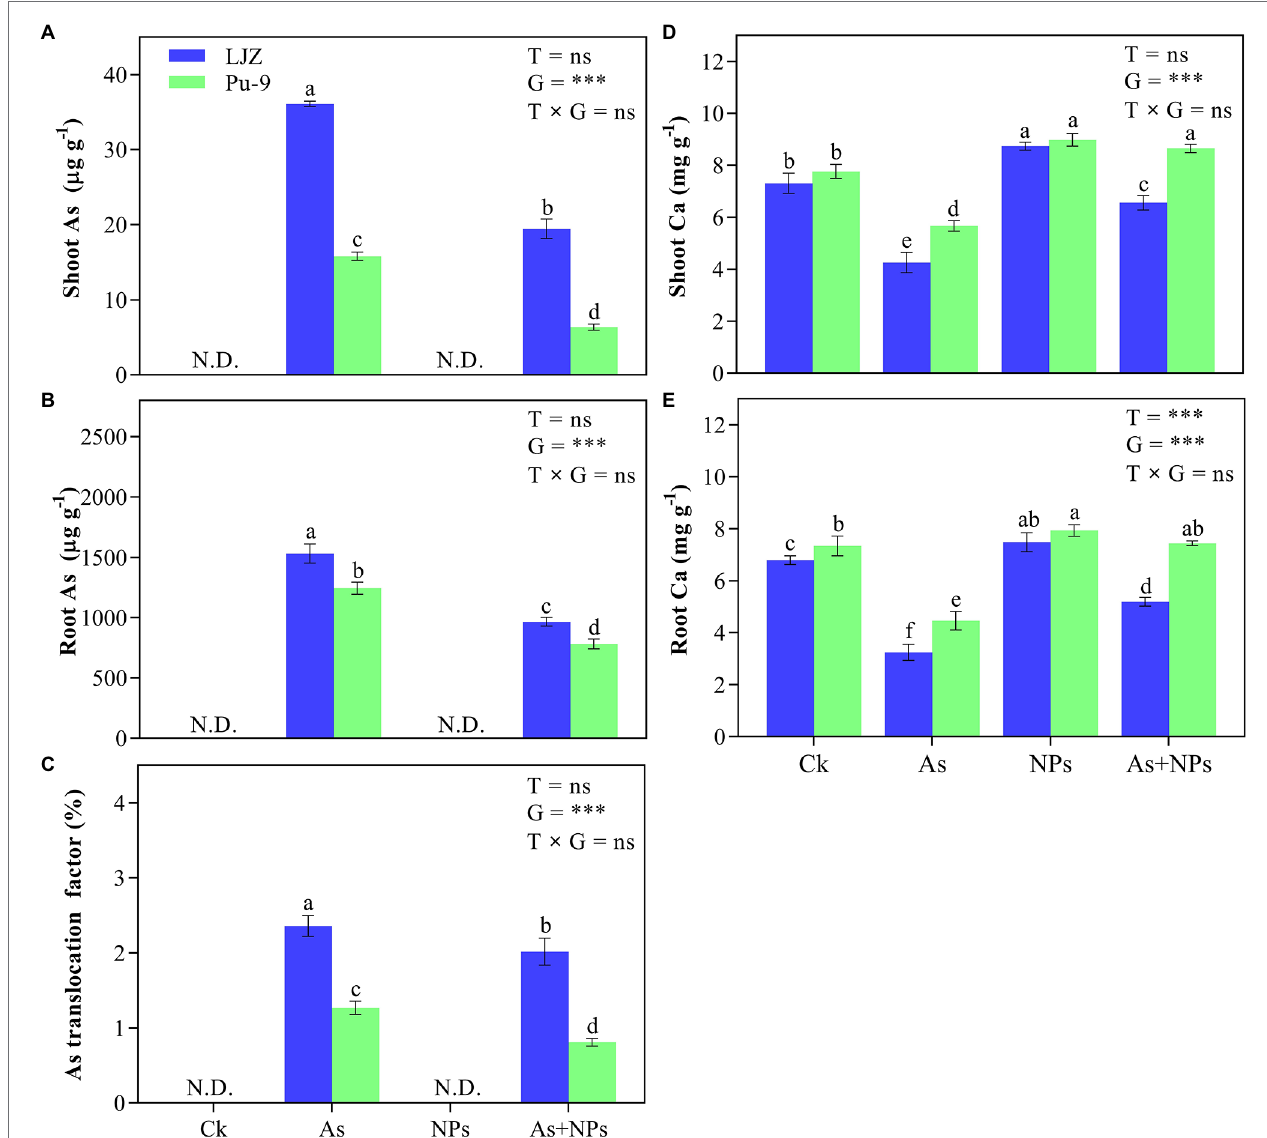
FIGURE 6 | Effects of the different treatments on Ca, As contents, and translocation factor in barley tissues. (A, B) As content in shoots and roots; (C) translocation factor; (D, E) Ca content in shoots nd roots. Different letters above error bars indicate the significant difference between treatments and genotypes at p ≤ 0.05. T, treatment; G, genotype; T × G, the interaction between treatment and